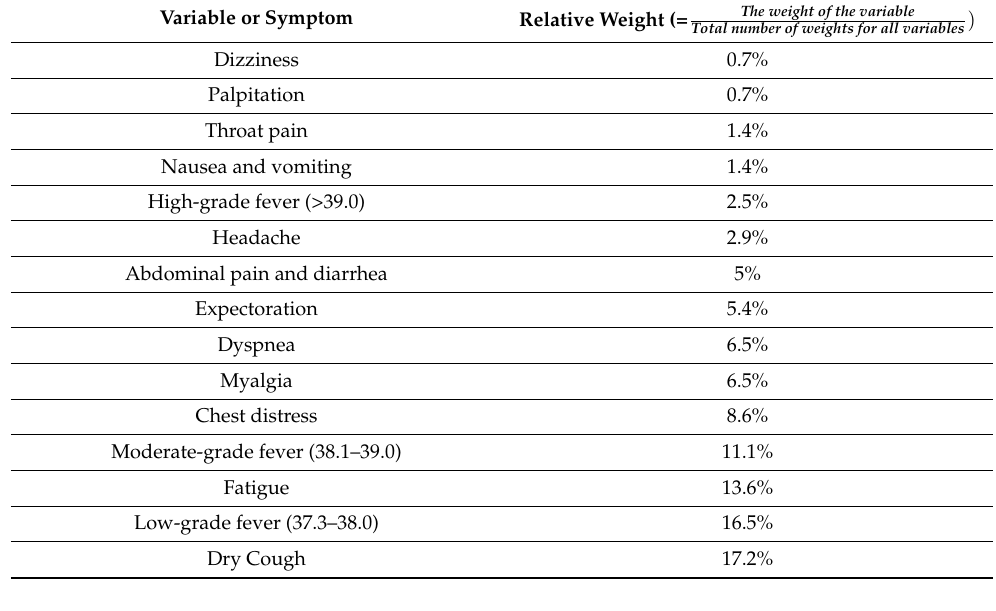
Table 6. The variables of the chest CT image, along with their calculated relative weights.